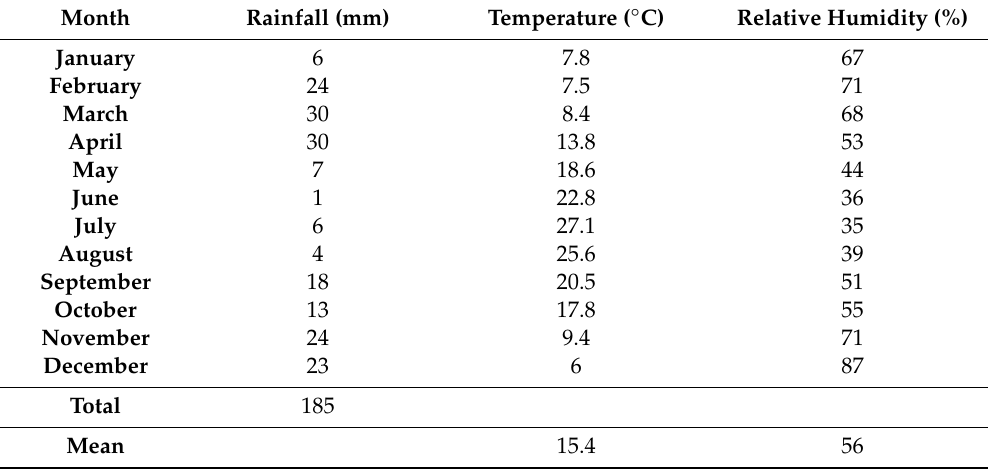
Table 1. Climatic conditions recorded in the region of Djelfa (south of Algeria) during